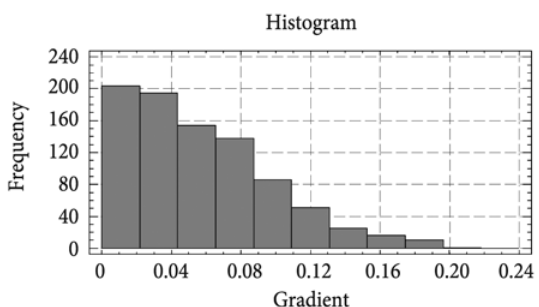
Fig. 5. Frequency of the gradient digital value repetition